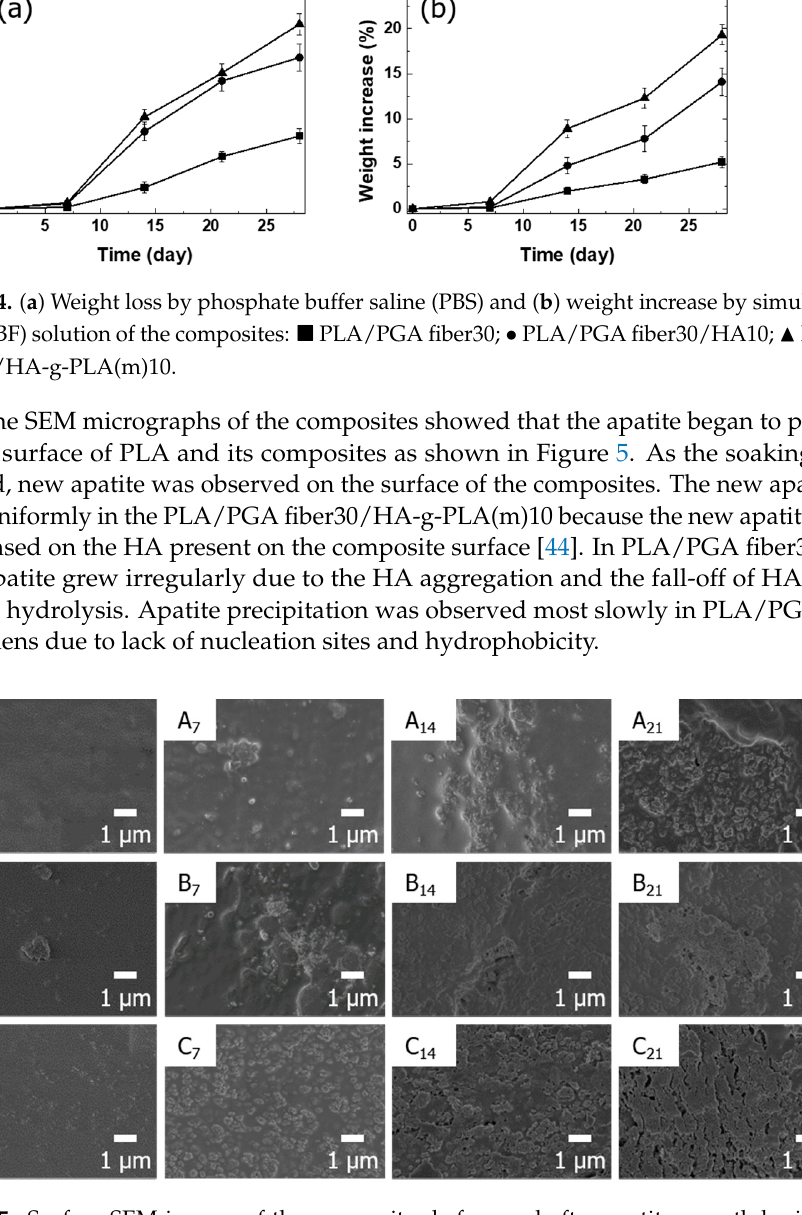
Figure 5. Surface SEM images of the composites before and after apatite growth by immersing PLA/PGA fiber30 ( A ), PLA/PGA fiber30/HA10 ( B ), and PLA/PGA fiber30/HA-g-PLA(m)10 ( C ) in SBF solution. The subscript number represents the immersing days of the composites.